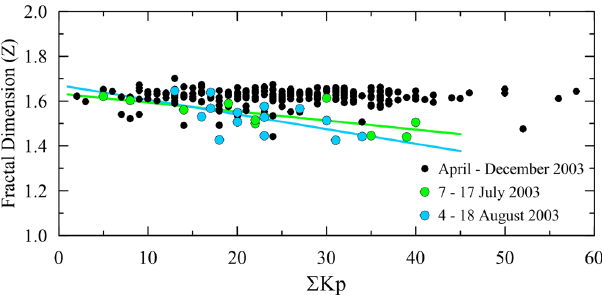
Fig. 2. Scatterplot of 6 Kp and the fractal dimension of the geomag- netic field Z component during the entire period reported in Fig. 1 (black dots) and during the two periods in which the presumed pre- cursors occurred. See text for